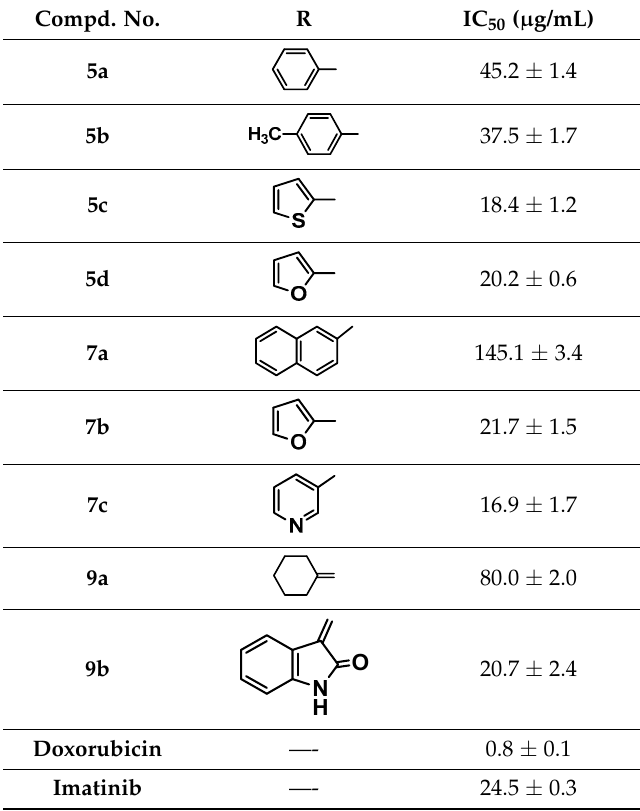
Table 1. The antitumor activities of the tested bis -thiadiazoles 5a – d , 7a – c , 9a , b . Compd. No.